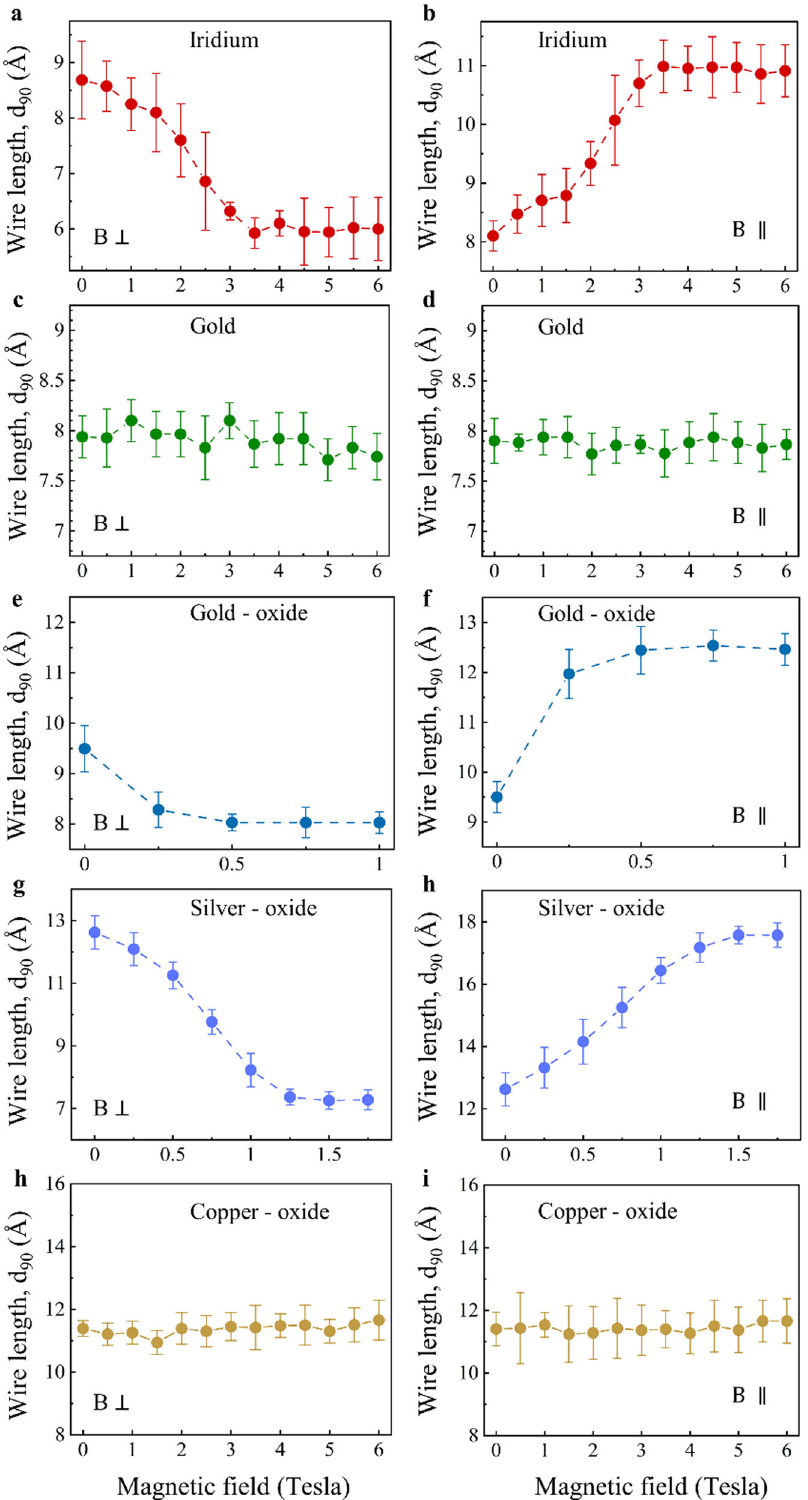
Fig. 6 Magneto-structural effects in different atomic wires. a – i d 90 as a function of perpendicular (left column) and parallel (right column) magnetic fi eld for iridium ( a , b ), gold ( c , d ), gold-oxide ( e , f ), silver-oxide ( g , h ), and copper-oxide ( h , i ) atomic wires. Each data point provides the average d 90 obtained from 5 different length histograms of 3000 traces each. Error bars present the standard deviation at each data point.